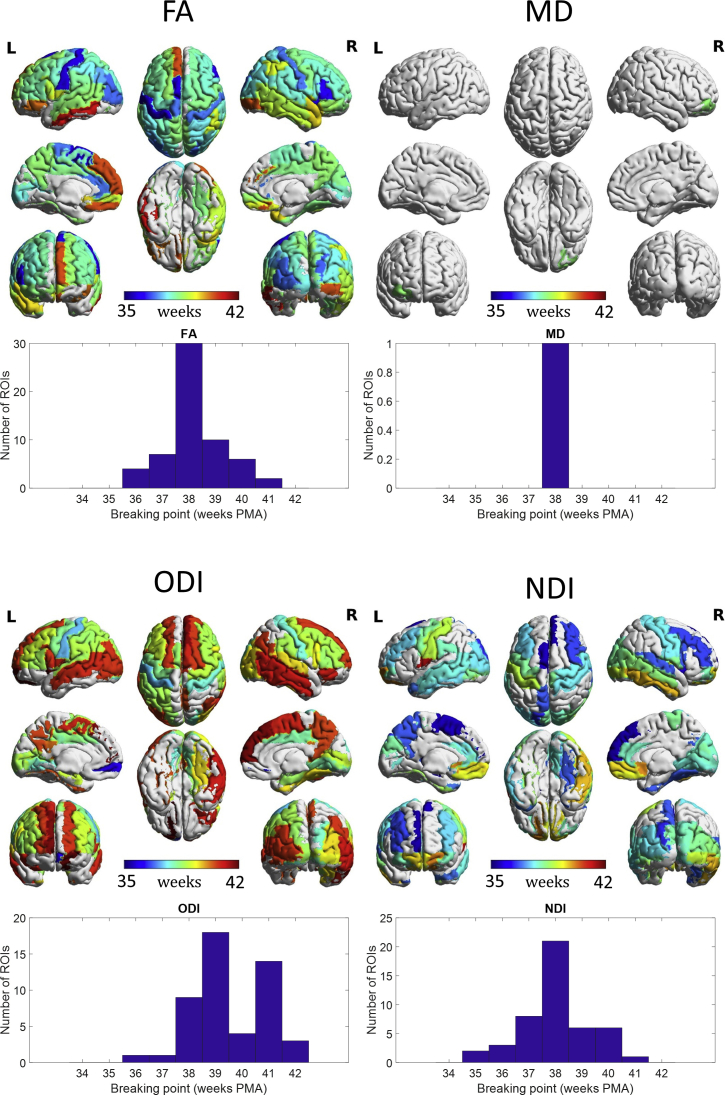
Region-wise biphasic linear regression breaking points (weeks PMA) of DTI and NODDI characteristics, and their histogram. We considered only breaking points between 1st and 3rd quartile of PMA distribution (35-42 weeks) corresponding to a biphasic model with a corrected Akaike Information Criteria (cAIC) inferior to the cAIC of a monophasic linear regression and with a significant (p<0.05) correlation at either side of the breaking point.